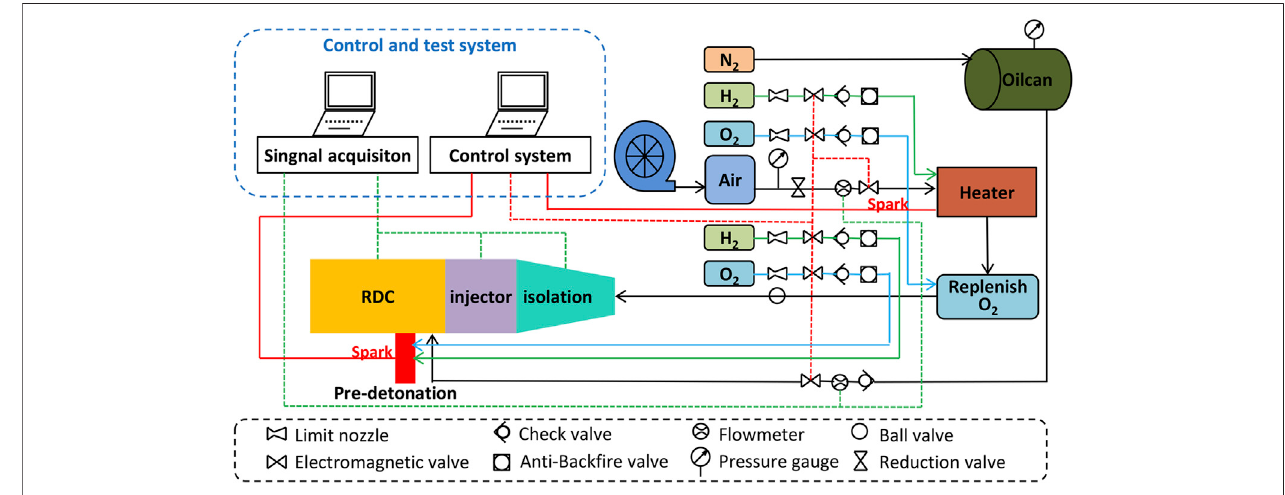
FIGURE 1 | Experimental system diagram.